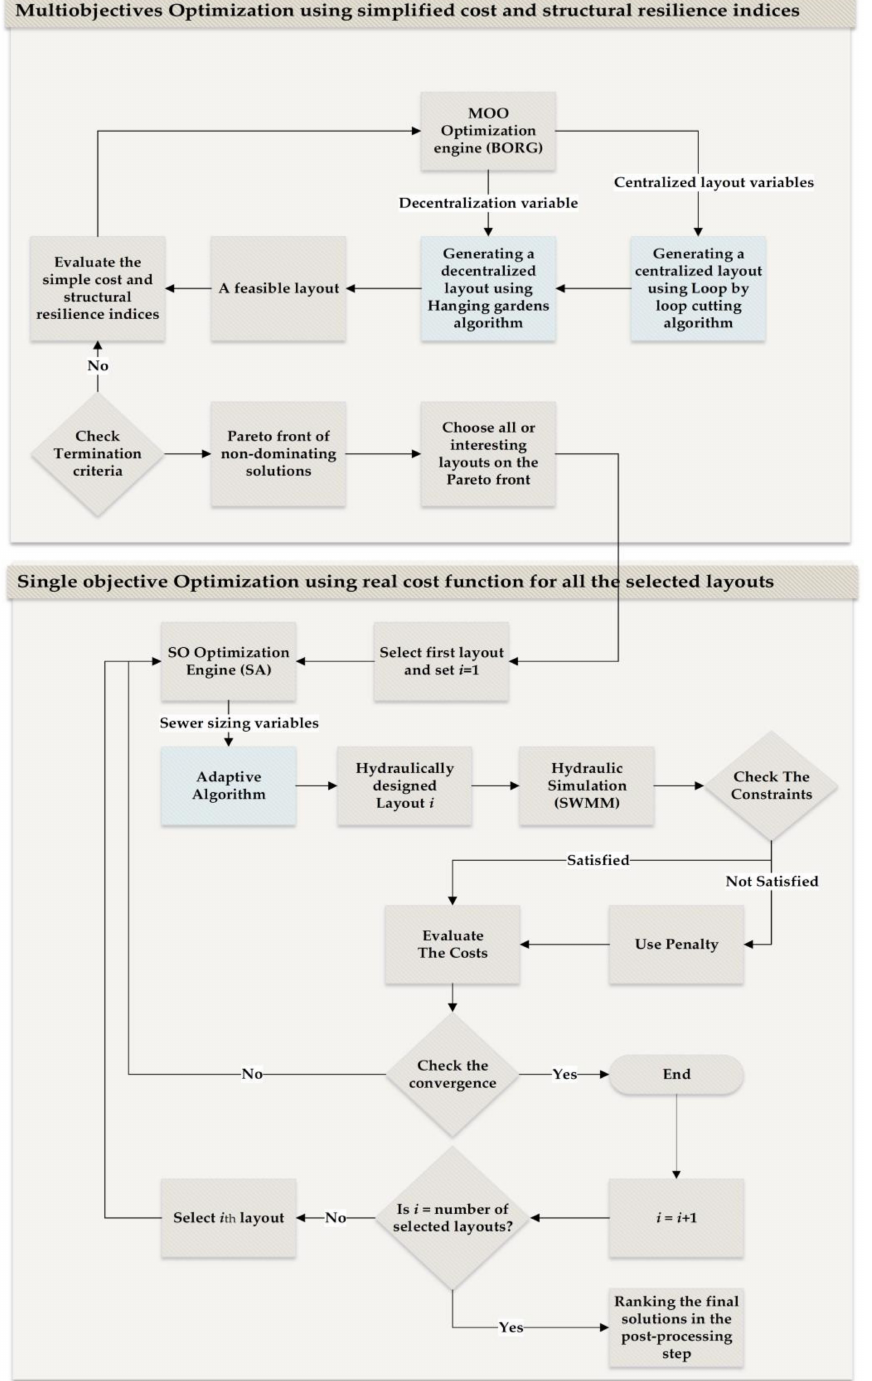
Figure 1. Multi-objective optimization and structural resilience analysis